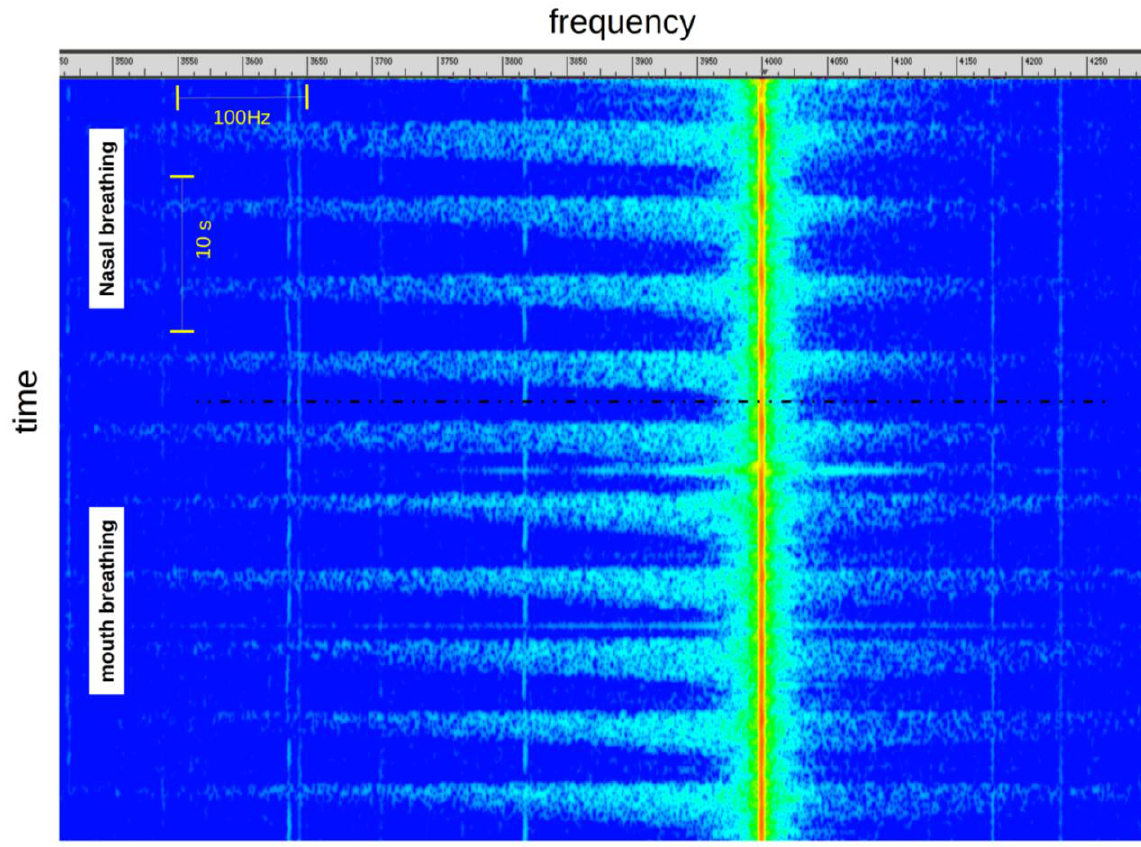
Figure 6. Signal visualization during nasal and mouth breathing.